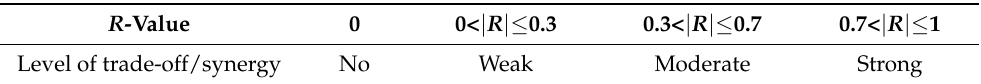
Table 1. Table of Correspondence Between R -Value and Level of Trade-off/Synergy. R -Value